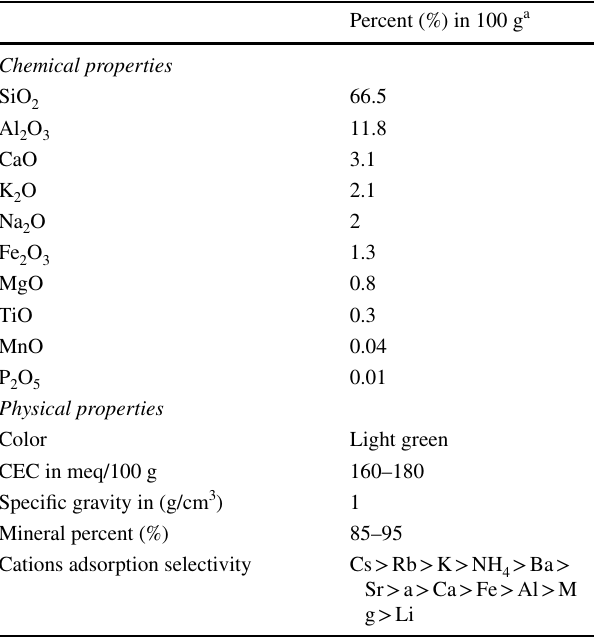
Table 1 Chemical and physical properties of Anzymite